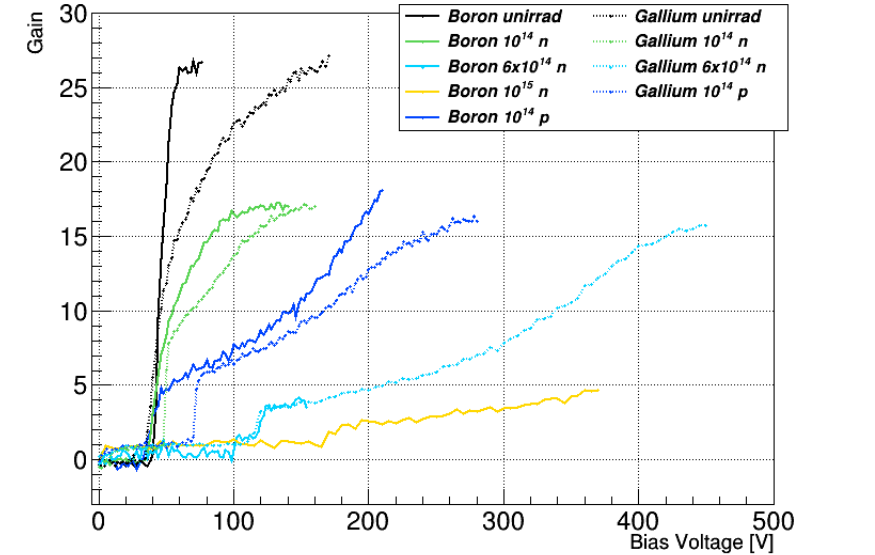
Figure 8. Gain for the boron and gallium CNM LGADs irradiated up to a fluence of 10 15 n eq /cm 2 at −